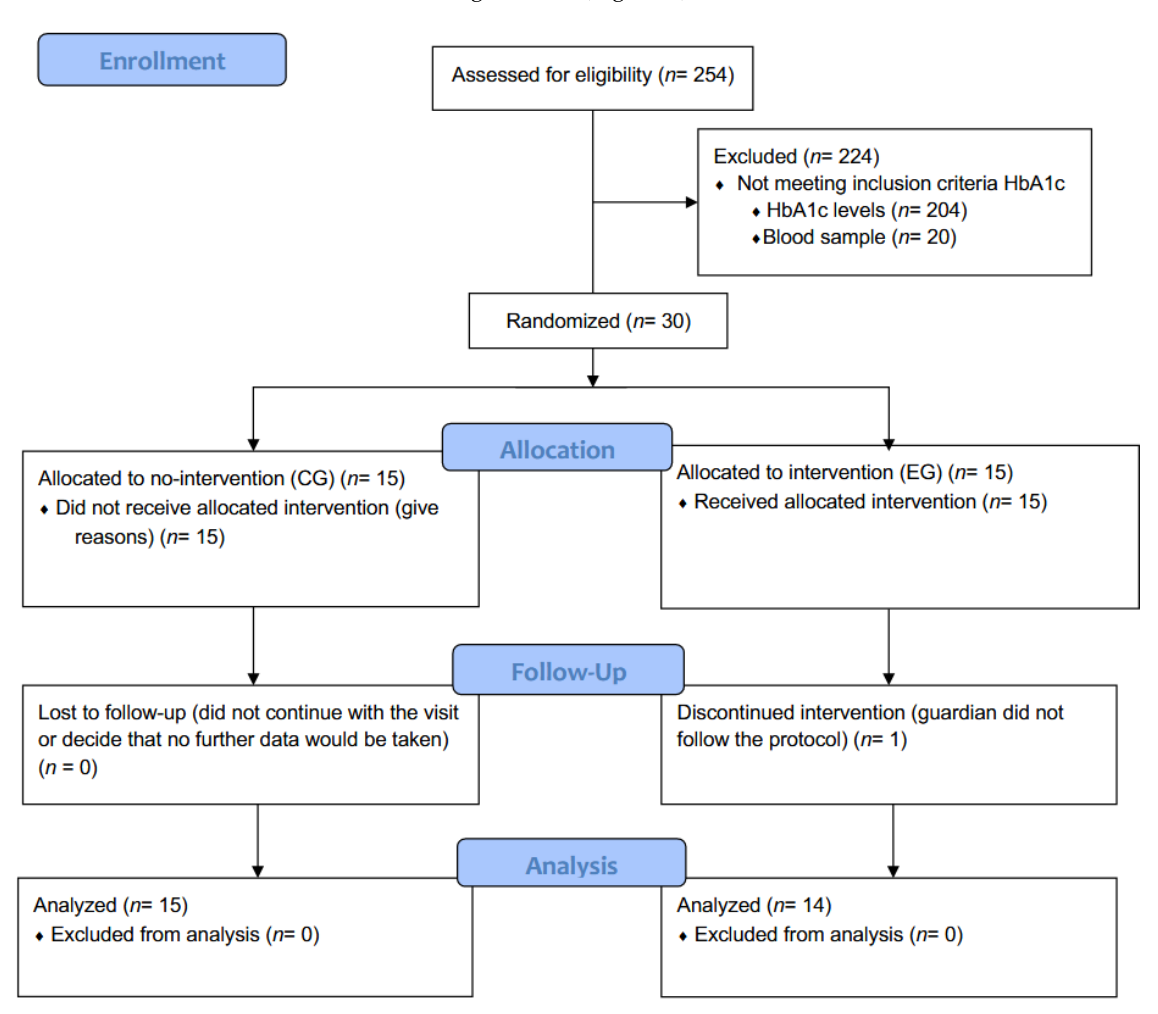
Figure 1. Flow diagram of the selection and randomization of the sample following the CONSORT guidelines.